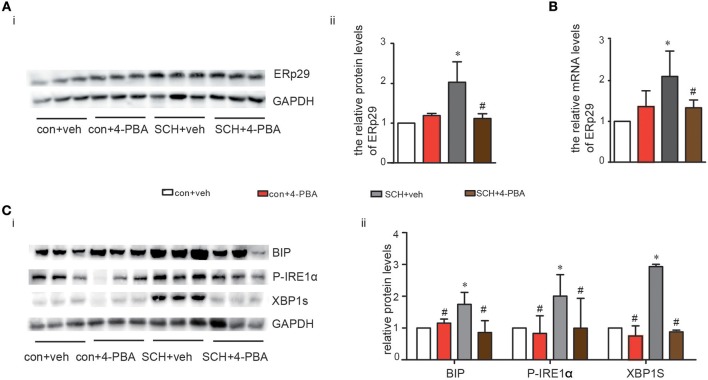
4-PBA alleviated hepatic ERS in SCH mice. We established SCH mouse model using MMI. When MMI was applied for 14 weeks, 4-PBA was given at a dose of 100 mg/kg·BW·d for 4 weeks, and mice were divided into four subgroups (as shown in Supplementary Figure 1): vehicle treated control mice group (con + veh group), 4-PBA treated control mice group (con + 4-PBA group), vehicle treated SCH mice group (SCH + vehicle group), and 4-PBA treated SCH mice group (SCH + 4-PBA group). (A) The protein expression of ERq29 was detected by western blot (n = 4–6). (B) The mRNA expression of ERq29 was detected by Real-time PCR. (C) The expression of proteins in the Bip/IRE1α/XBP-1 pathway were detected by western blot (n = 4–6). The data are presented as the mean ± SD. *p < 0.05 compared with control. #p < 0.05 compared with SCH.